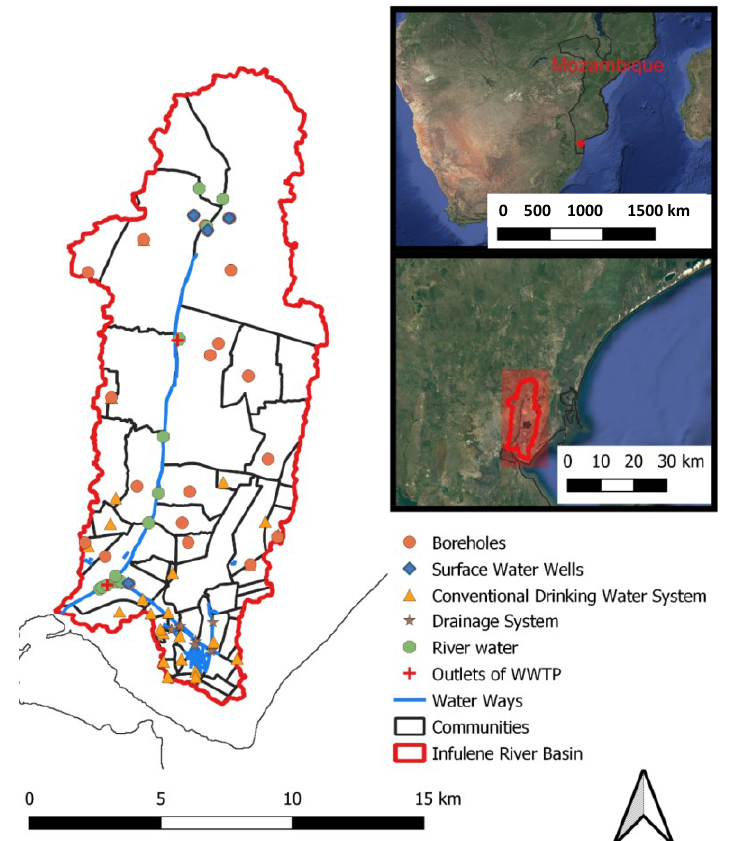
Figure 1. Study area and sampling points .